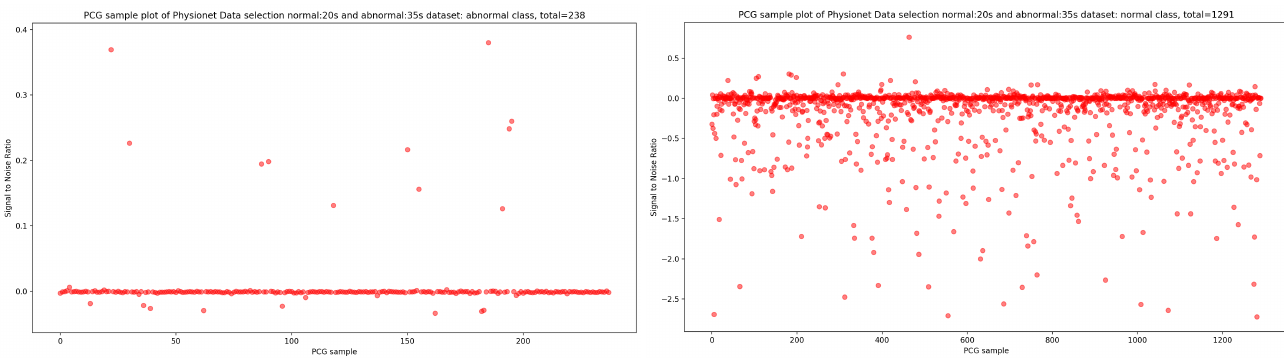
Figure 6. An overview of the SNR distribution in function of KDE density related to normal and abnormal samples after applying the KDE duration selection process.